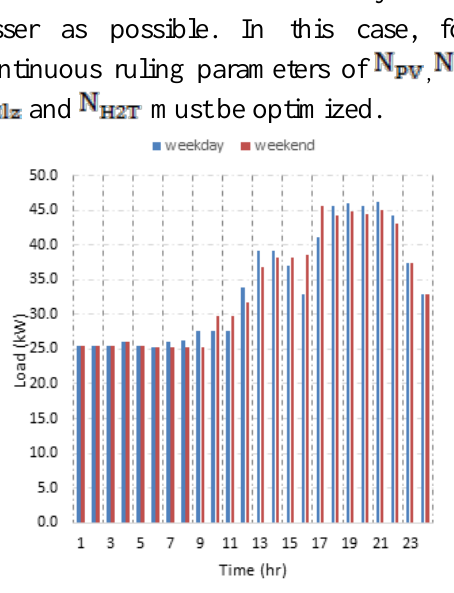
Fig. 3: The daily load profile of the studied